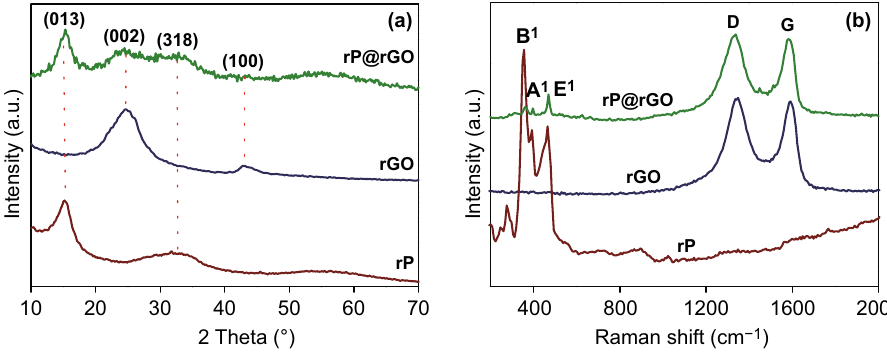
Fig. 4 a XRD pattern and b Raman spectra of rP, rGO, and